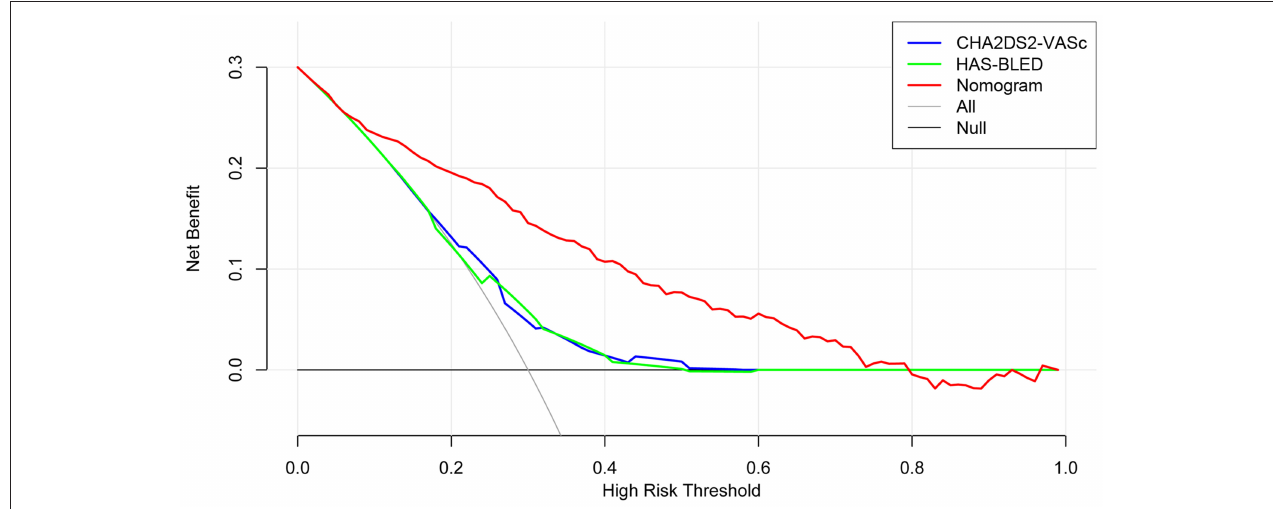
FIGURE 6 | Decision curve analysis of the nomogram, CHA 2 DS 2 -VASc score and HAS-BLED score. The y-axis represents the net benefit and the x-axis represents the threshold probability. The null plot represents the assumption that no patients survive, while the all plot represents the assumption that all patients survive at a specific threshold